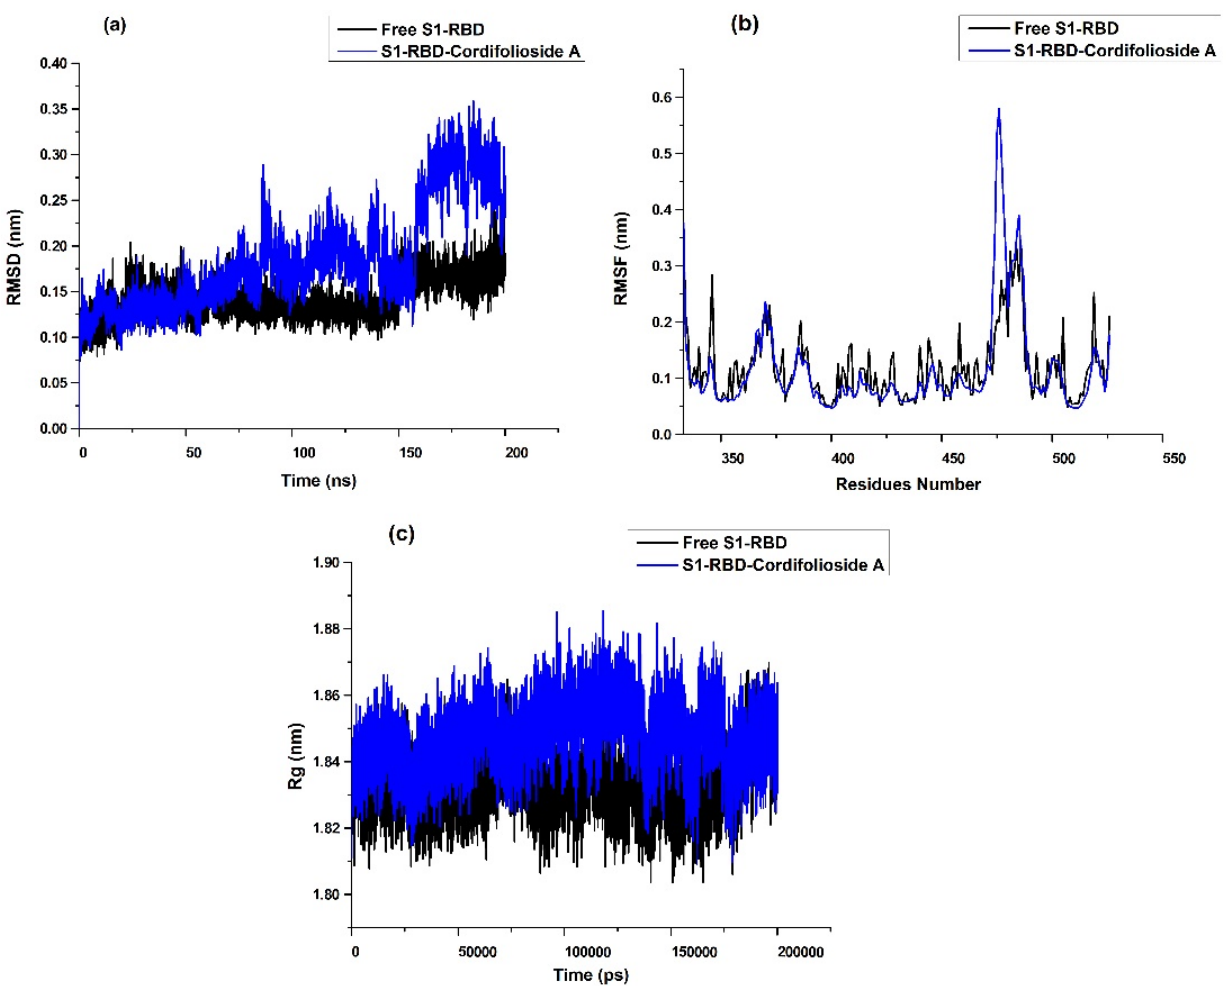
Figure 3. ( a ) RMSD of the atomic positions for the free S1-RBD and S1-RBD-cordifolioside A; ( b ) RMSF of the atomic positions for the free S1-RBD and S1-RBD-cordifolioside A; ( c ) radius of gyration for the free S1-RBD and S1-RBD-cordifolioside A for 200 ns MD simulation using GROMACS package. Hydrogen bonding interactions are important in the protein–ligand complexes. To explore hydrogen bonds, the intermolecular interactions of ligands in complex with the S1-RBD region during simulation were computed within the last 1 ns trajectory of